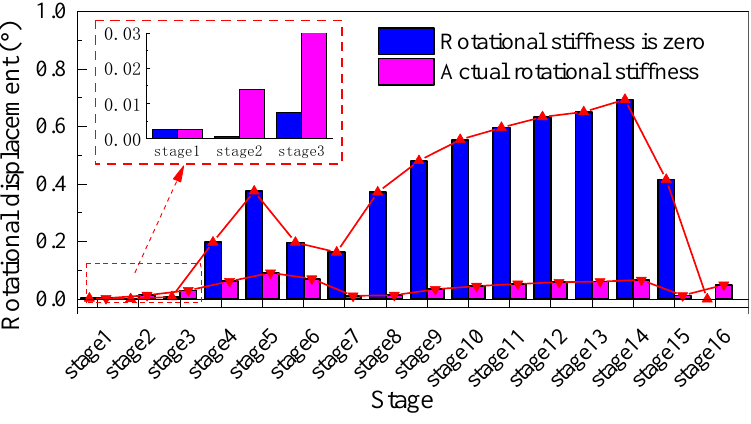
Figure 20. Comparison of the rotation displacement of the bridge tower.